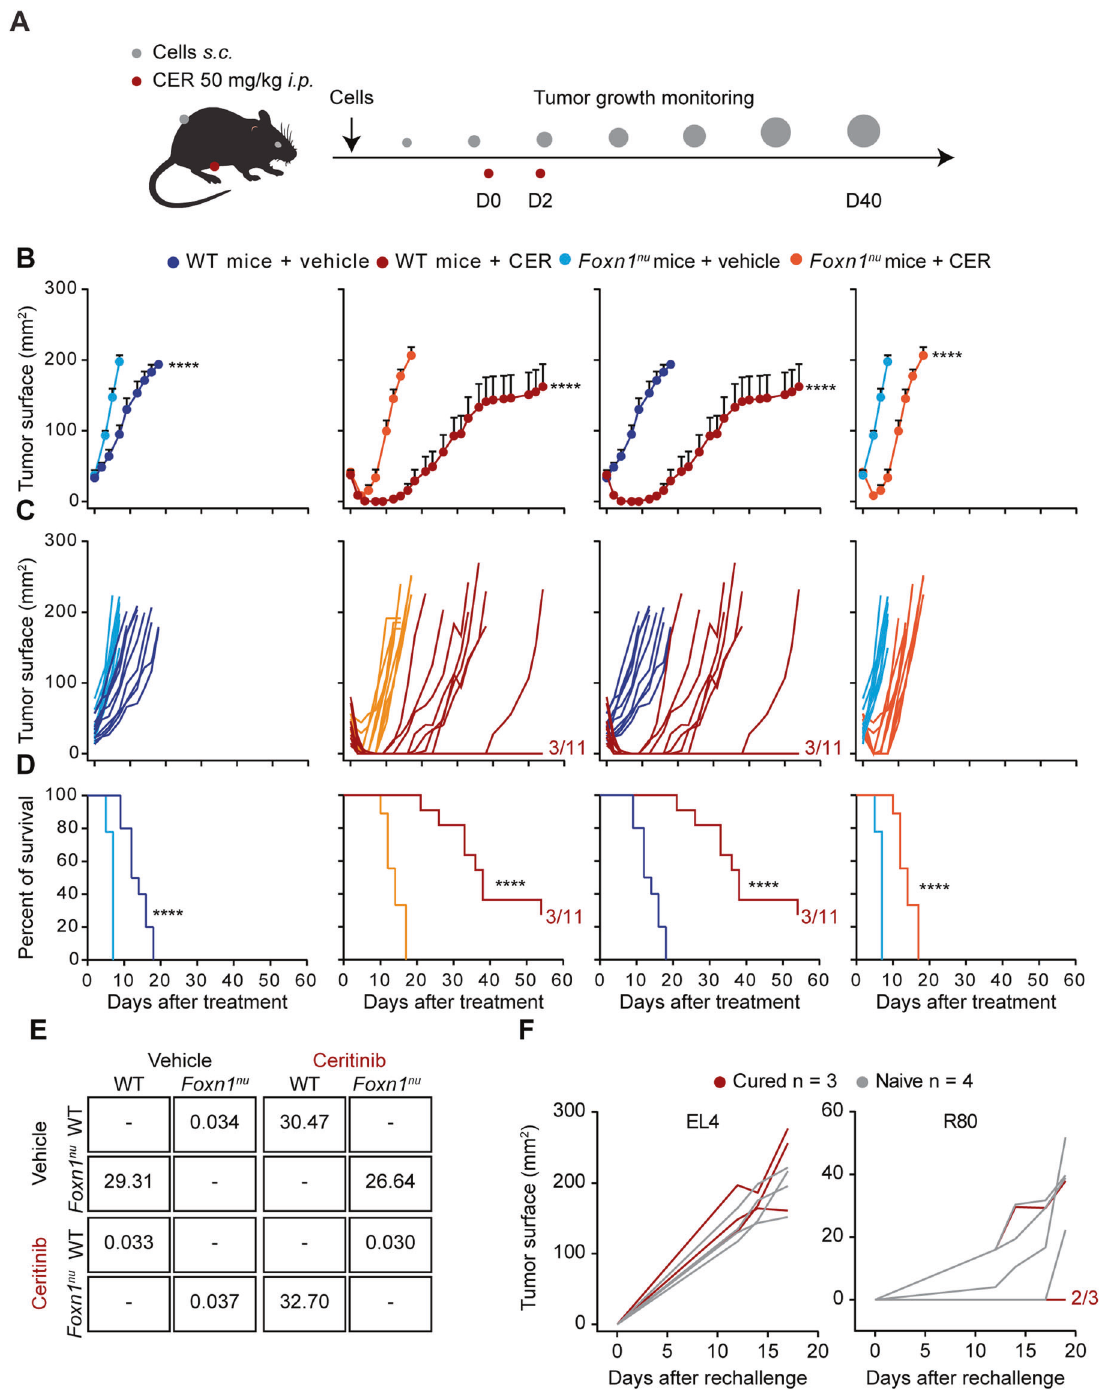
Fig. 6 Immune-dependent effect of ceritinib in ALK-driven lymphoma. One million NPM1-ALK + R80 cells were injected into the right fl ank of C57BL/6 or Foxn1 nu mice. When tumors reached a surface of 30 – 35 mm 2 mice were randomized and treated with ceritinib (CER, 50 mg/Kg i. p.) or vehicle control on the day of the randomization (d0) and 2 days later (d2) ( A ). Tumor surface is represented as mean ± SEM of mice belonging to the same group ( B ) or for single mice ( C ). Survival is depicted in D . Hazard ratio (Mantel – Haenszel) relative to the comparison between survivals of immunocompetent vs immunode fi cient mice or vehicle-treated vs ceritinib-treated is shown in E . Vehicle immunocompetent n = 10; vehicle immunode fi cient n = 9; CER immunocompetent n = 11; CER immunode fi cient n = 9. tumor growth curves were compared using a type II ANOVA test, while statistical signi fi cance of survival was calculated using the Log-rank test. **** p < 0.0001. Cured mice ( n = 3) and naïve controls ( n = 4) were challenged with 1 × 10 6 R80 into the left fl ank and 5 × 10 5 of unrelated lymphoma cells, EL4, into the right fl ank. Tumor growths of EL4 and R80 lymphomas are shown in F .